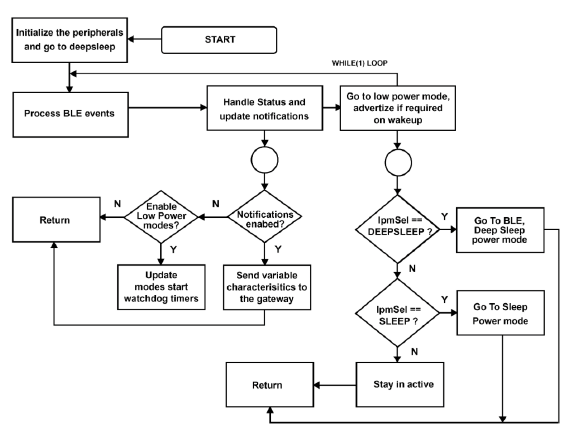
Figure 7. The simplified diagram flow of the deep sleeping mode process configuration of the BLE sensor node.